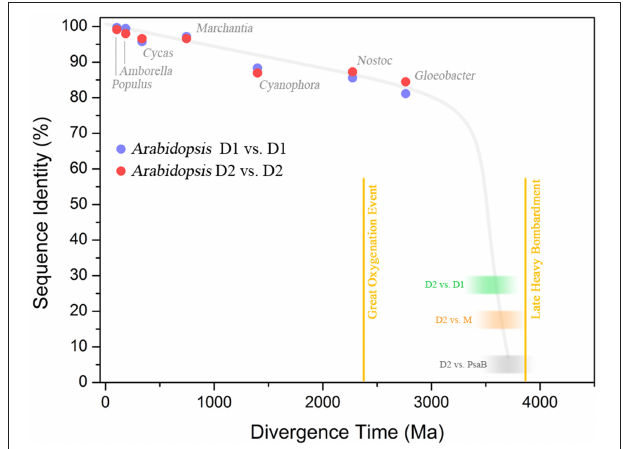
FIGURE 6 | Sequence identity of Photosystem II reaction center proteins as a function of time. The blue dots show the percentage of sequence identity between the D1 protein sequence of Arabidopsis thaliana compared to that in other organisms. The red dots show the percentage of sequence identity of D2. The green blurred box shows the level of sequence identity between D1 and D2 of Arabidopsis and the blur represents uncertainty. The orange box shows the sequence identity of D2 compared to theM subunit of Chloroflexus aurantiacus. The gray box shows the sequence identity of D2 compared to the PsaB subunit of Photosystem I from Thermosynechococcus elongatus . This was calculated by overlaying the 3D structures of D2 and PsaB proteins and counting the conserved residues (the identity is below 5%), see Cardona (2015). The plot shows that D1 and D2 have been changing at an almost constant rate since the Great Oxygenation Event (GOE) around 2.4 billion years ago. It also highlights that the events that led to the divergence of Type I from Type II reaction centers (gray box), the anoxygenic from oxygenic Type II reaction centers (orange box), and D1 from D2 (green box), must have occurred very early in the history of life. It is also likely that these early events in the evolution of photosynthesis probably occurred relatively fast after the origin of the first reaction center protein. The divergence times in plant evolution were taken from Clarke et al. (2011). The time for Cyanophora paradoxa , representing the origin of plastids, was assumed to be in between 1.1 and 1.5 Ga (Butterfield, 2000; Yoon et al., 2004). The time for Nostoc sp. PCC 7120, representing the origin of heterocystous Cyanobacteria, was assumed to have occurred after the GOE (Golubic et al., 1995; Tomitani et al., 2006). The divergence of the genus Gloeobacter violaceus sp. PCC 7421 was assumed to have occurred before the GOE. The divergence time for D1/D2, D2/M, and D2/PsaB are hypothetical, but in order to explain the origin and diversification of photosynthesis within the age constraints of planet Earth, very fast rates of evolution are needed at the earliest stages. It suggests that the earliest stages of Photosystem II evolution, such as the divergence of D1 and D2, might have occurred soon after the origin of photochemical reaction